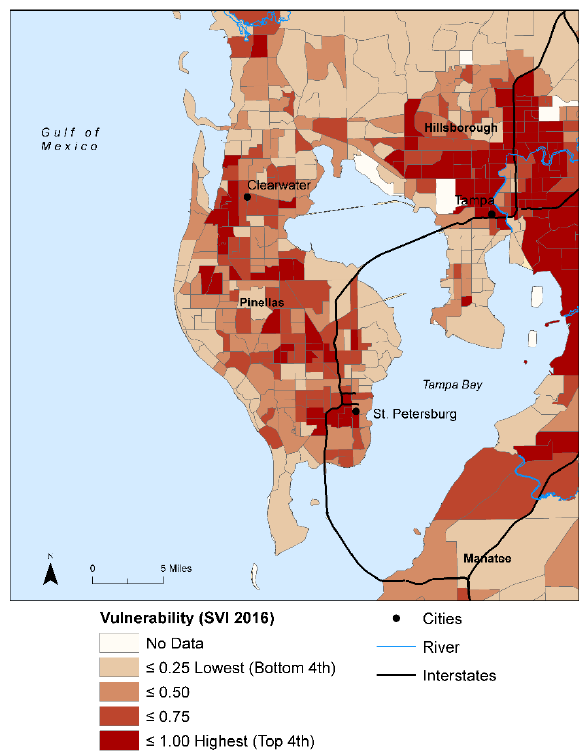
Figure 1. Geophysical and social vulnerability in Pinellas County. Atmosphere 2020 , 11 , x FOR PEER REVIEW